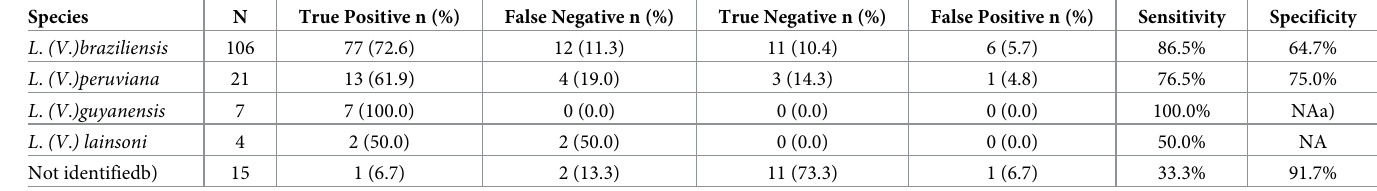
Table 5. Modified CL Detect Rapid Test Sensitivity and Specificity by Species of Samples Collected by Lancet–All Subjects.